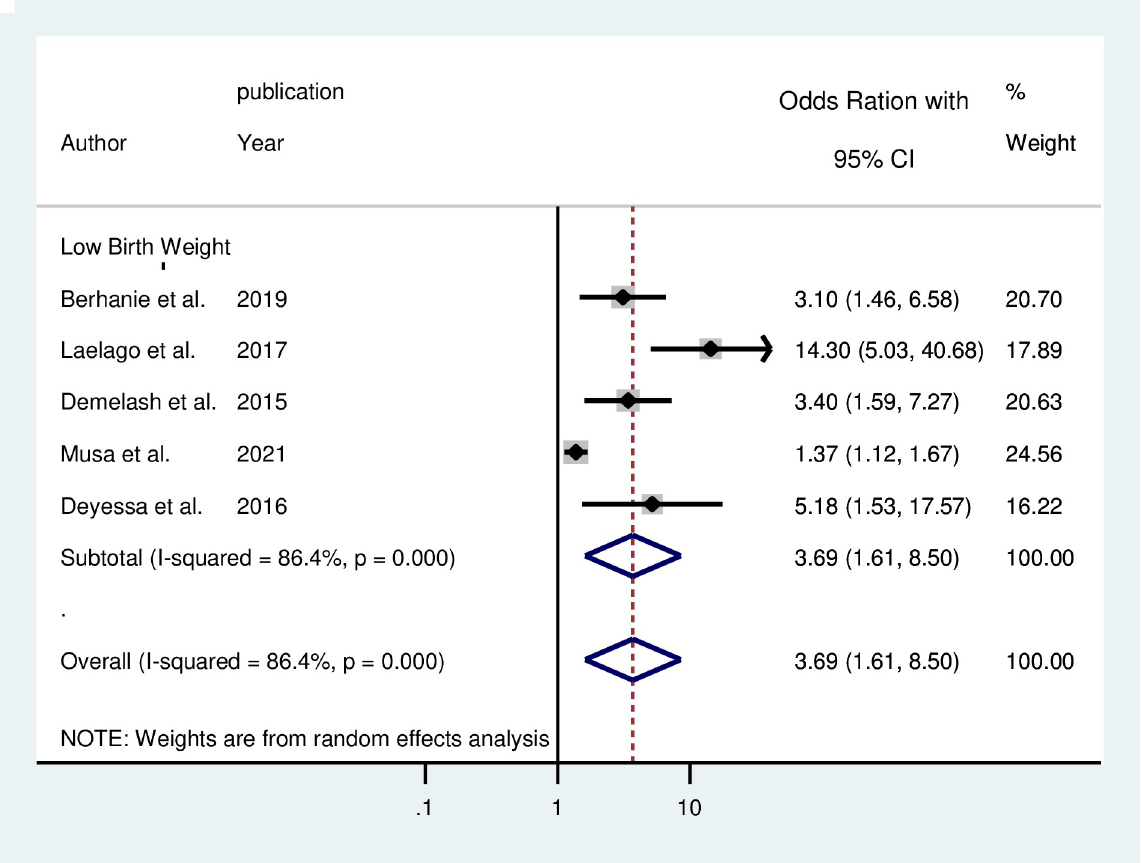
Fig 4. Forest plot for the pooled association between intimate partner violence during pregnancy and low birth weight.